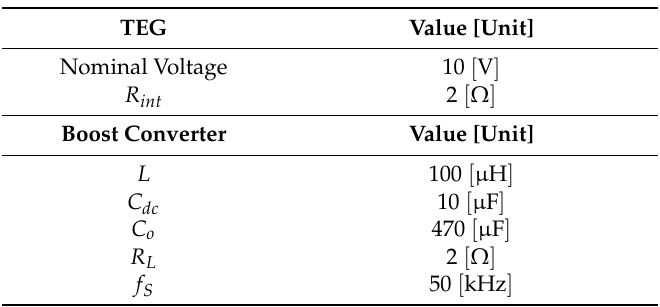
Table 1. Design parameters of the TEG module and Boost